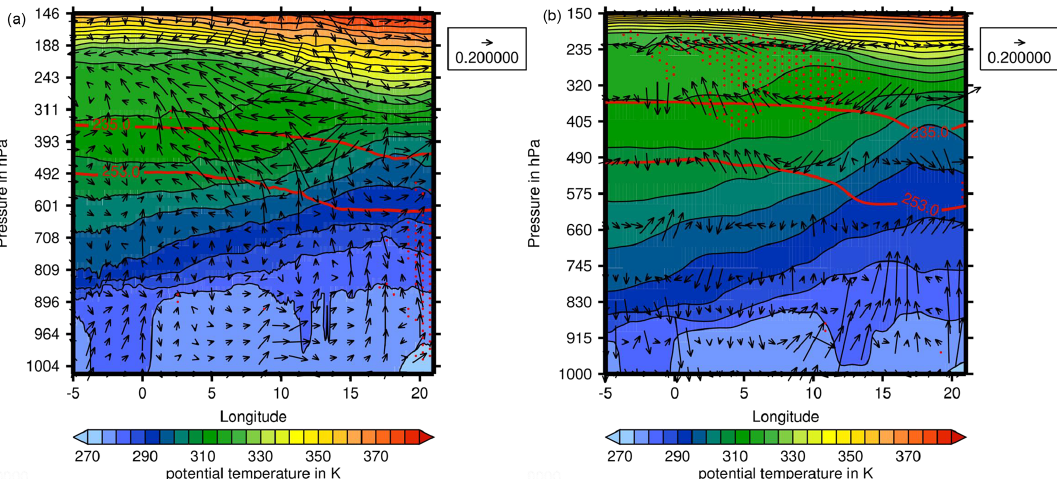
Figure 7. (a) Potential temperature field from ICON-EU. (b) The same field from ERA5. The arrows show zonal and vertical wind compo- nents, differently normalized in both directions, so that the vertical motions are easily visible. Stippling indicates ice supersaturation, which at temperatures above 235K implies the presence of a mixed-phase or supercooled-water